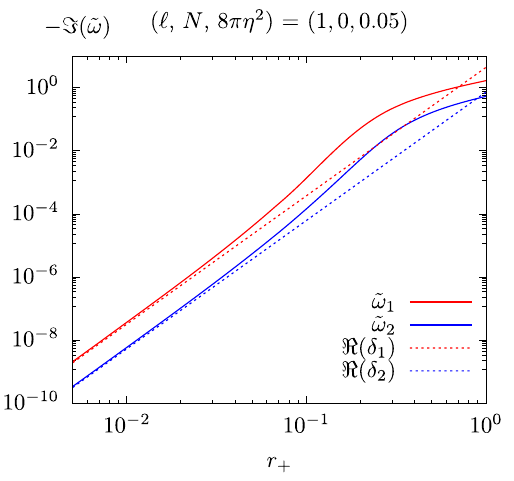
Fig. 1 Comparison of the imaginary part of quasinormal frequencies for the two sets of fundamental modes with (cid:2) = 1 and 8 πη 2 = 0 . 05, between the analytic matching approximation (dashed lines) and the numerical data (solid lines). Note that we use double logarithmic coor- dinates in this figure